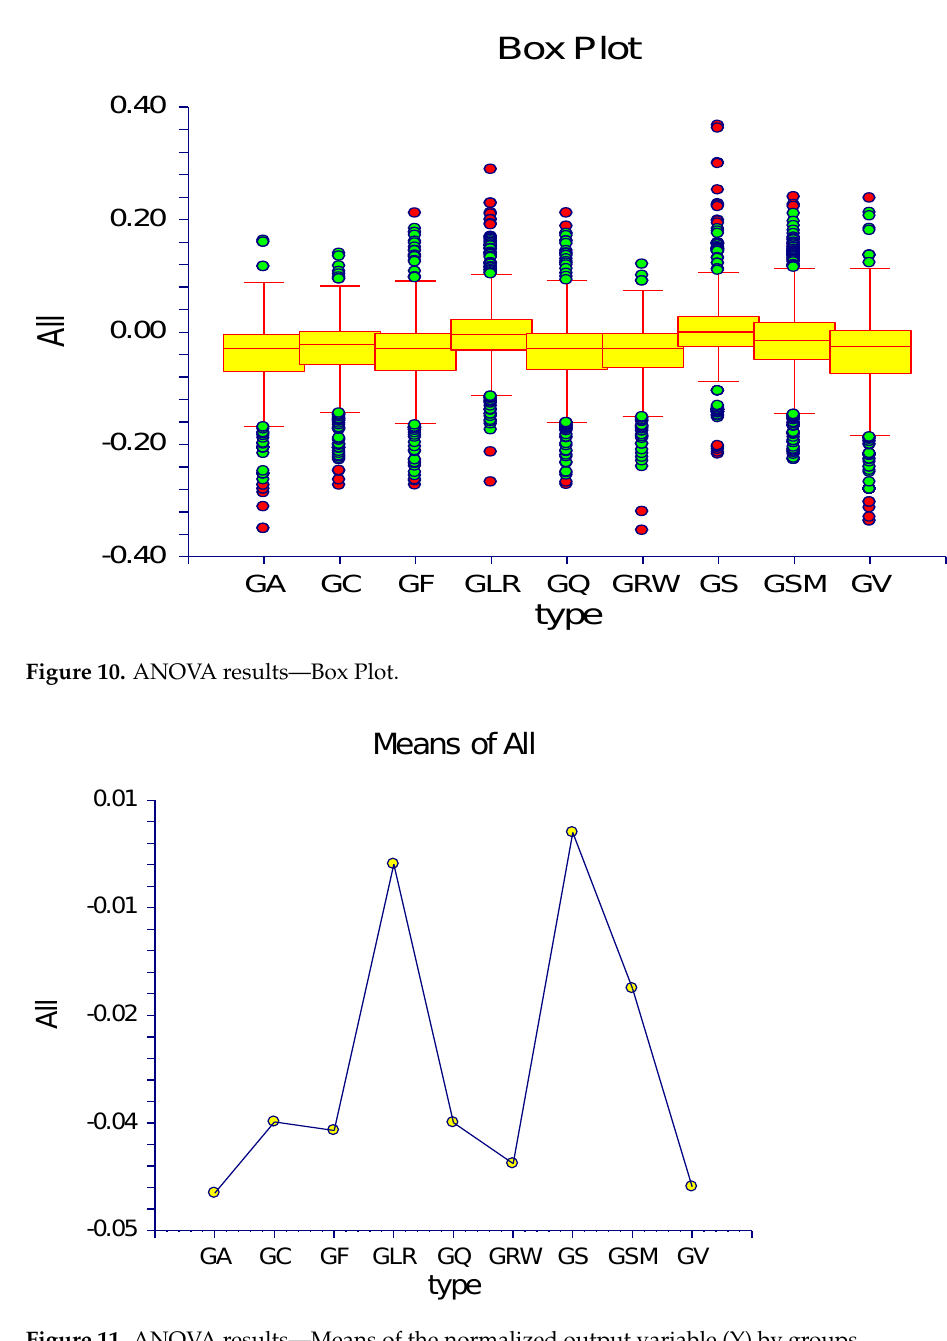
Figure 11. ANOVA results — Means of the normalized output variable (Y) by groups.